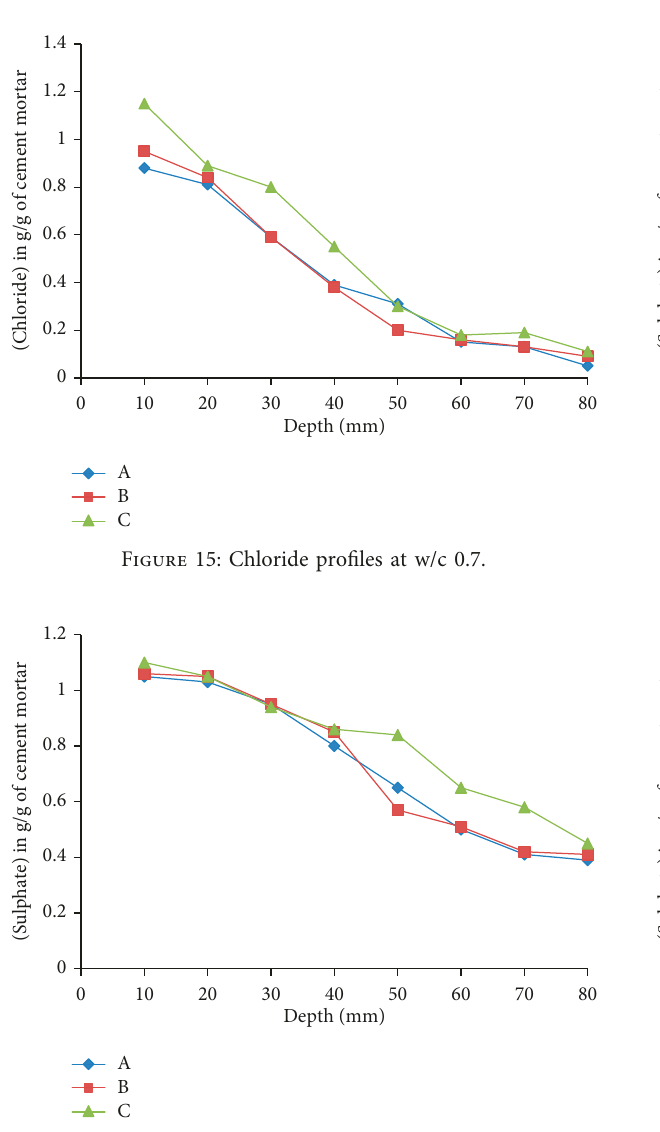
Figure 18: Sulphate profiles at w/c